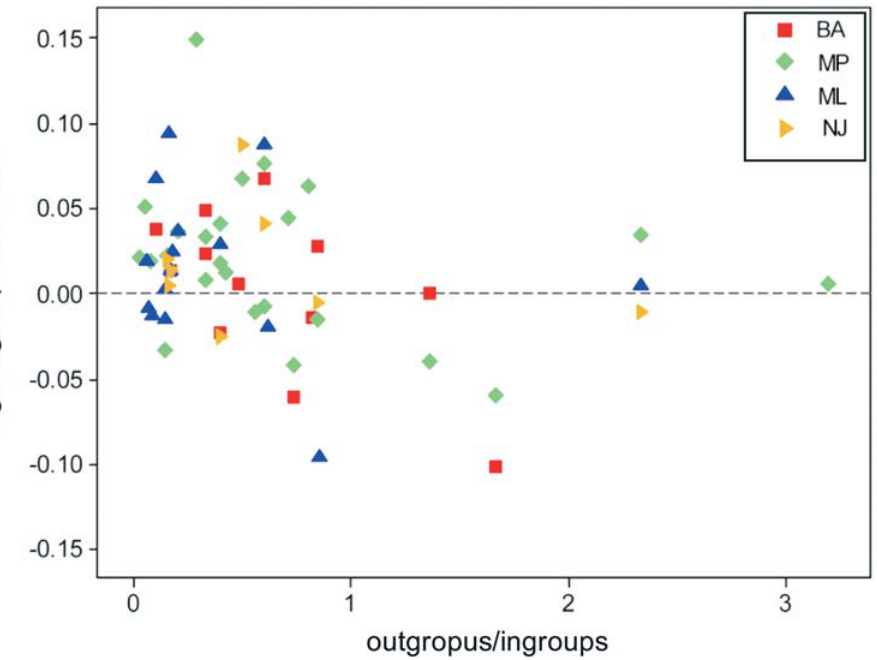
Figure 5. Values of log outgroup imbalance plotted against the relative proportion of outgroups in the dataset of 61 published phylogenetic trees. Data points labeled as in Fig. 4.